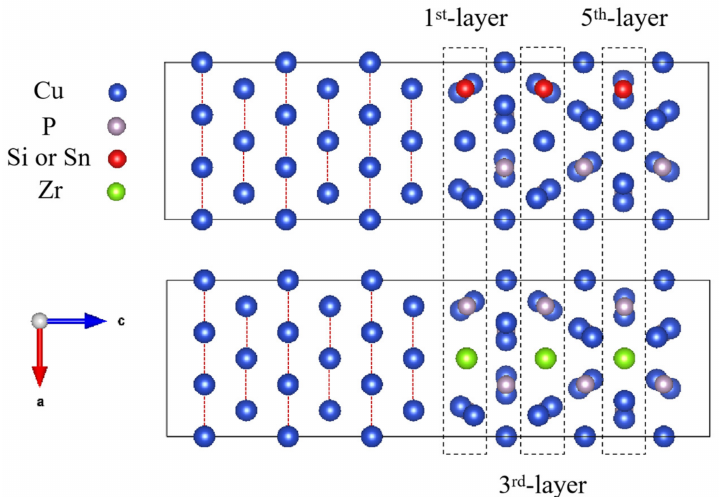
Figure 5. Local deformation of the atomic interface structure induced by elements (Si, Sn, and Zr) before and after interfacial relaxation of CuP/Cu.